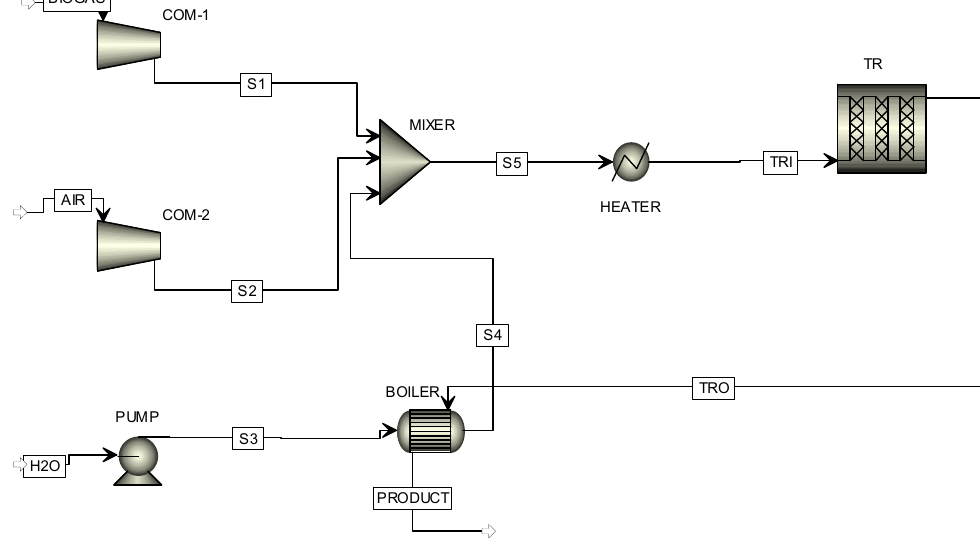
Figure 1. Tri-reform process for syngas production using biogas as feedstock.